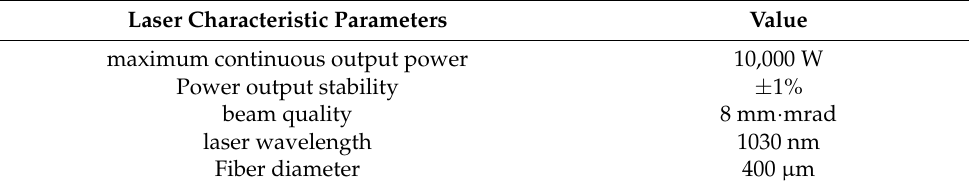
Figure 1. HLAW system. Table 1. Laser